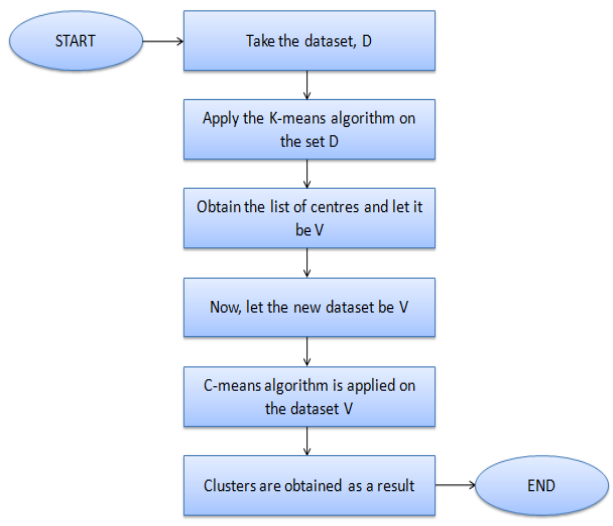
Fig. 5. KCM algorithm.